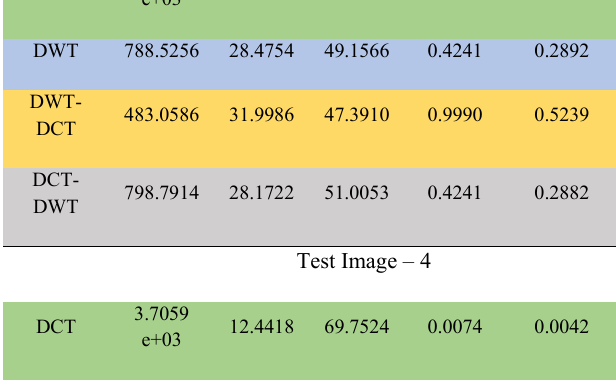
Figure 18. Comparison of Denoising Algorithms based on PSNR The variance coefficient for Hybrid Algorithm is given in Figure 19